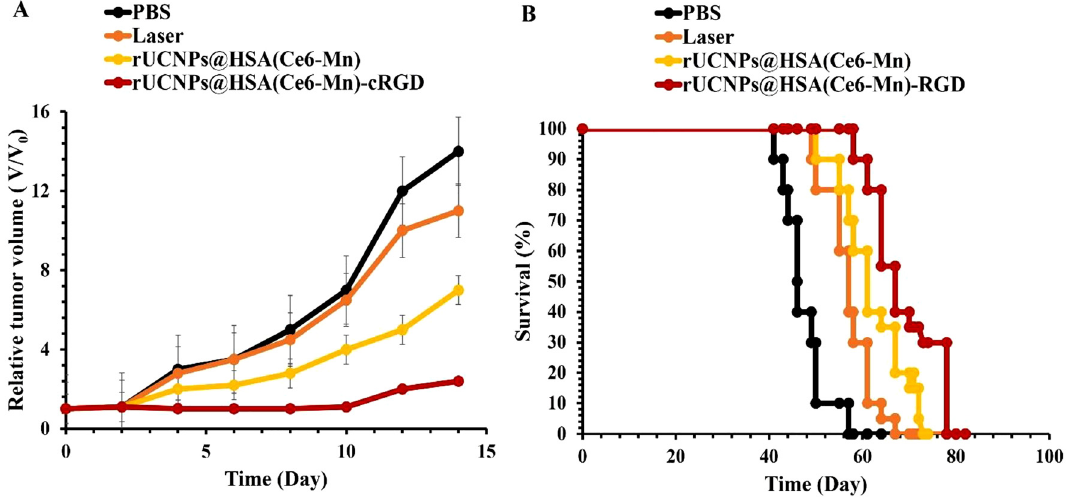
Figure 23: (A)The relative tumor volumeafter treatment with PBS (control), light only,rUCNPs@HSA(Ce6-Mn)or rUCNsP@HSA(Ce6-Mn)-RGD, witha concentrationof 5.2 mg/kg(Ce6equivalent) and(B)Kaplan – Meiersurvivaltimecurve.Light excitationat 980nm (1.5Wcm − 2 ) for5min. Adapted from Tang et al. [49,